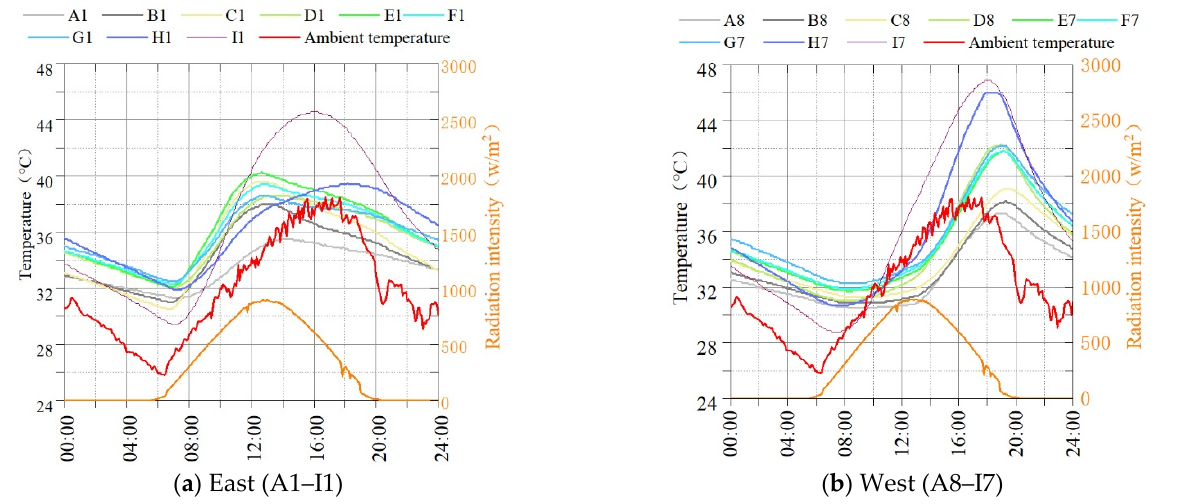
Figure 25. The relationship of wall temperature, atmospheric temperature and the strongest solar radiation (13 July 2017).